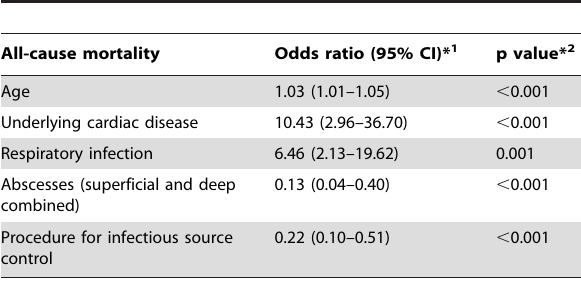
Table 4. Significant risk factors for mortality from S. aureus infection from multiple logistic regression